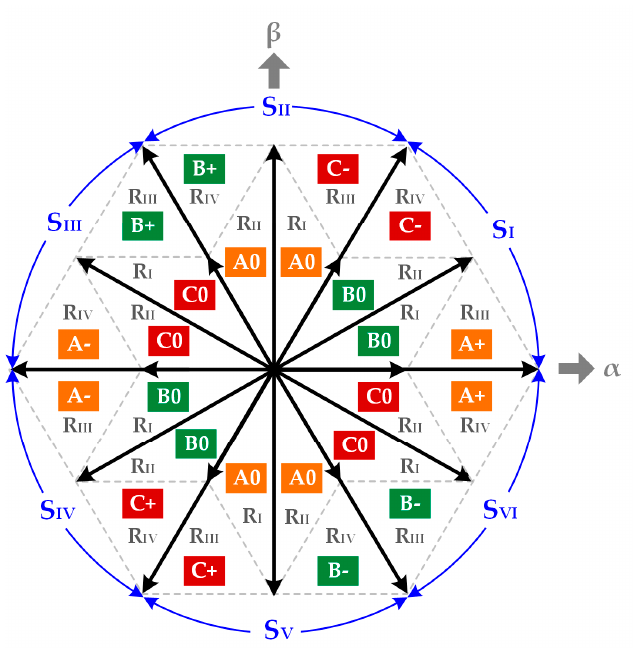
Figure 5. The clamping state in each region of the space vector diagram.